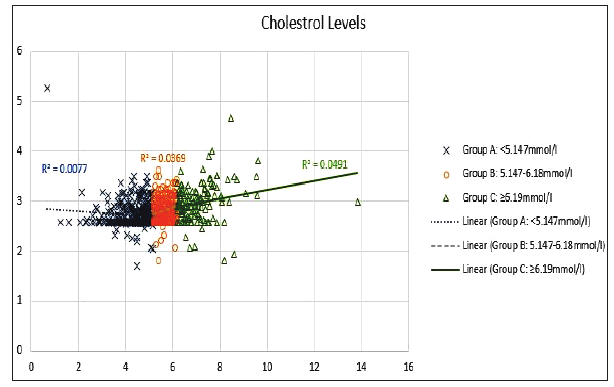
Fig-4: Correlation between Device method and laboratory method according to Cholesterol